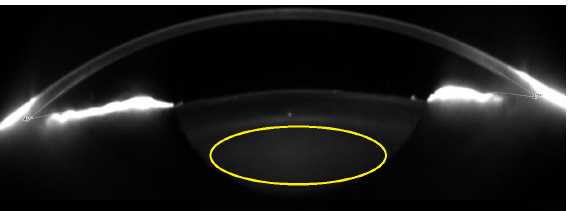
Fig 1. Region of Interest for Measuring the Nuclear Lens Density Superimposed upon the Scheimpflug Image Used.